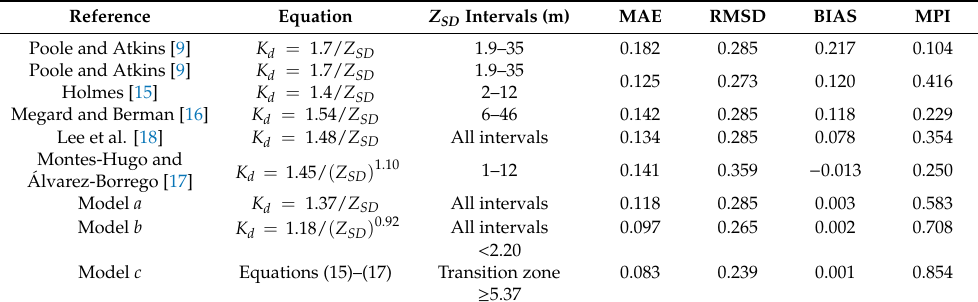
versus 𝑍 (cid:3020)(cid:3005) models. (cid:3046)(cid:3036)(cid:3047)(cid:3048)